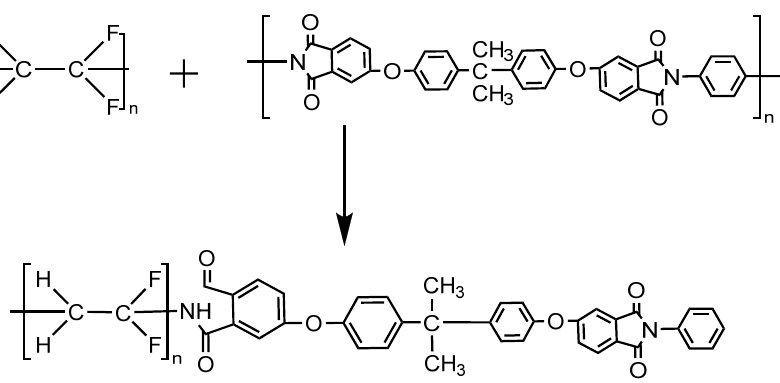
Figure 11. Mechanism of intermolecular chain reaction of PVDF/PEI blend membrane.